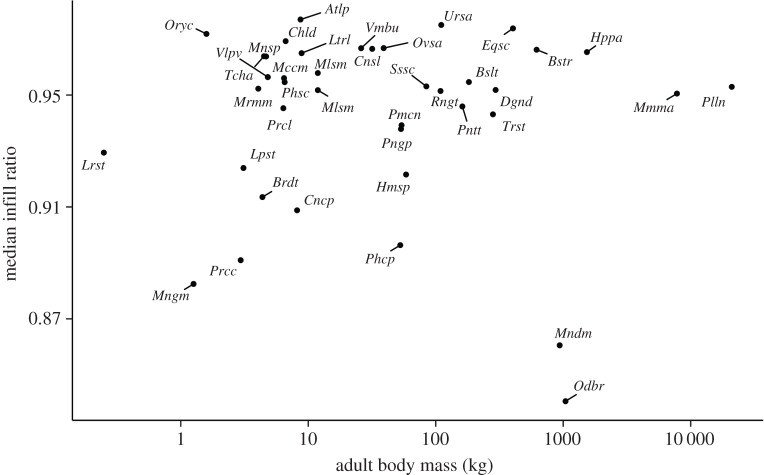
Log–log plot of per species median infill ratio and estimated body mass. Infill ratio does not scale with body mass, and is kept greater than 85% throughout mammalian species.